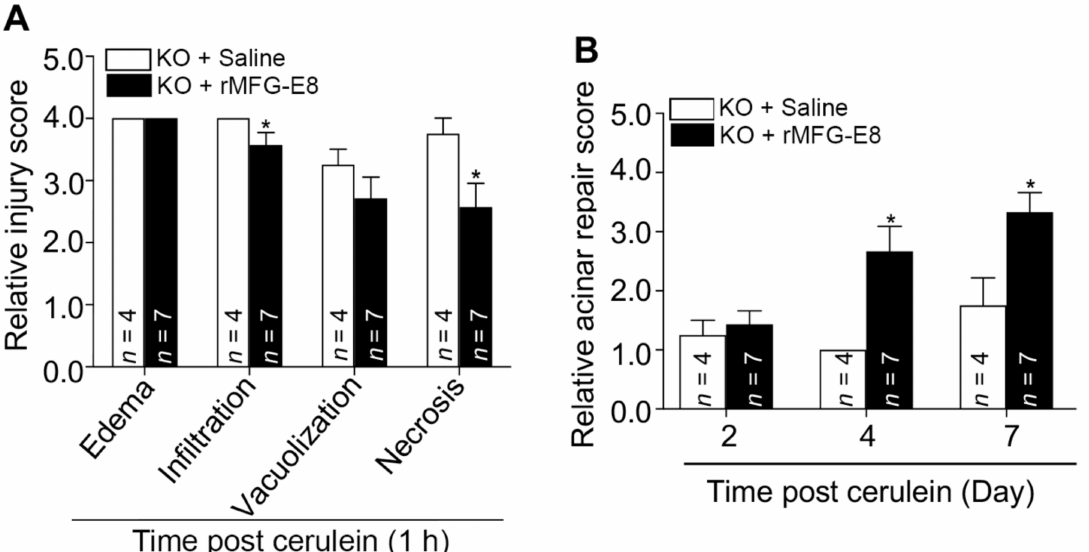
Figure 5. Recombinant mouse MFG-E8 protein (rMFG-E8) attenuates tissue injury and promotes acinar repair in Mfge8 KO mice with cerulein-induced acute pancreatitis. Mfge8 KO mice (male, 8–10 weeks old) were treated with saline or rMFG-E8 (20 µ g/kg, IP) 2 h before the first cerulein injection, then twice a day for 7 days. Animals were euthanized at 1 h after the last cerulein treatment ( A ) or at the indicated timepoints ( B ). The pancreas was processed for histological examination and the relative injury score (A) and acinar repair score (B) are presented here, based on the scoring systems in Tables 1 and 2, respectively. * p < 0.05 versus the cerulein-treated Mfge8 KO + saline